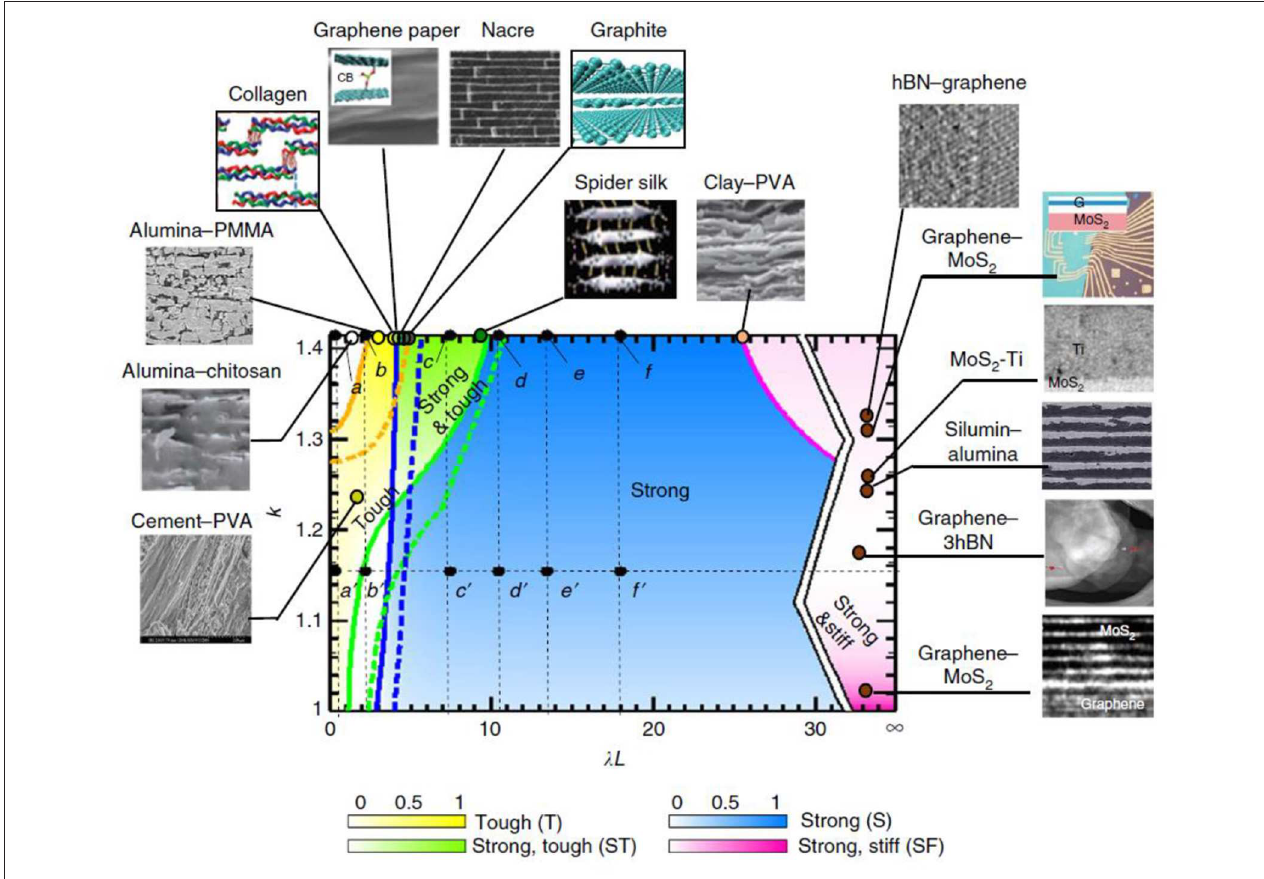
FIGURE 5 | Universal map for mechanical properties of nacre-mimetic hybrid structures obtained based on dimensionless parameters. Figure reproduced from Sakhavand and Shahsavari (2015), with permission from Springer